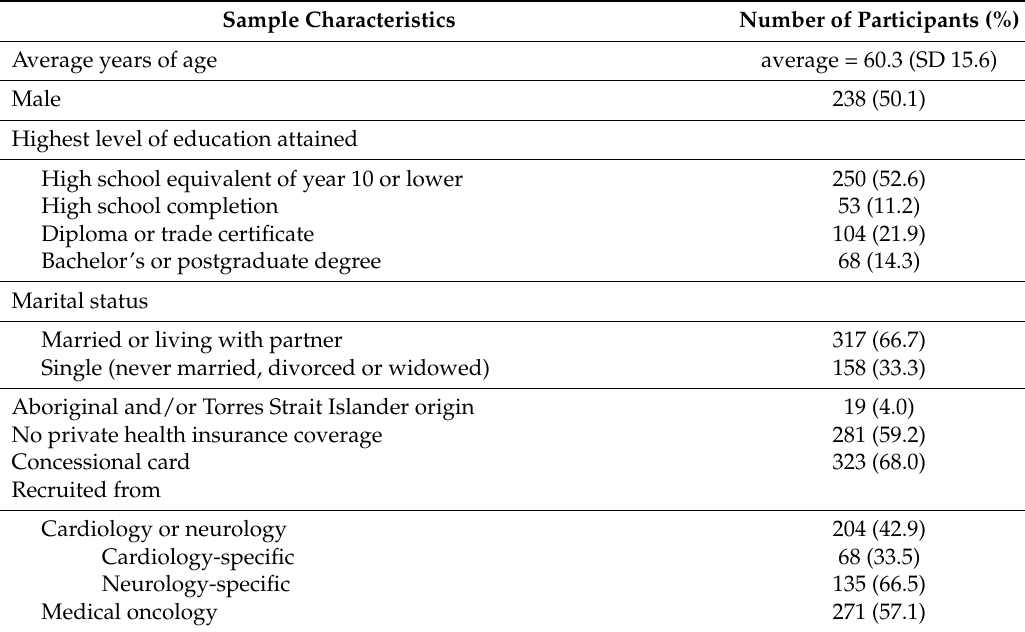
Table 1. Sample demographic and clinical characteristics ( n =